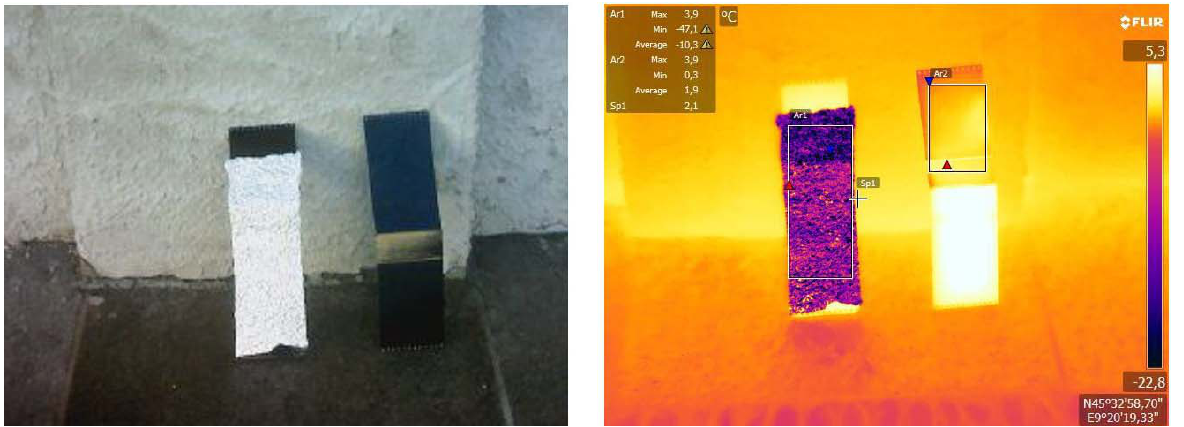
Figure 3. Visible image and thermogram of the cardboard box coated with